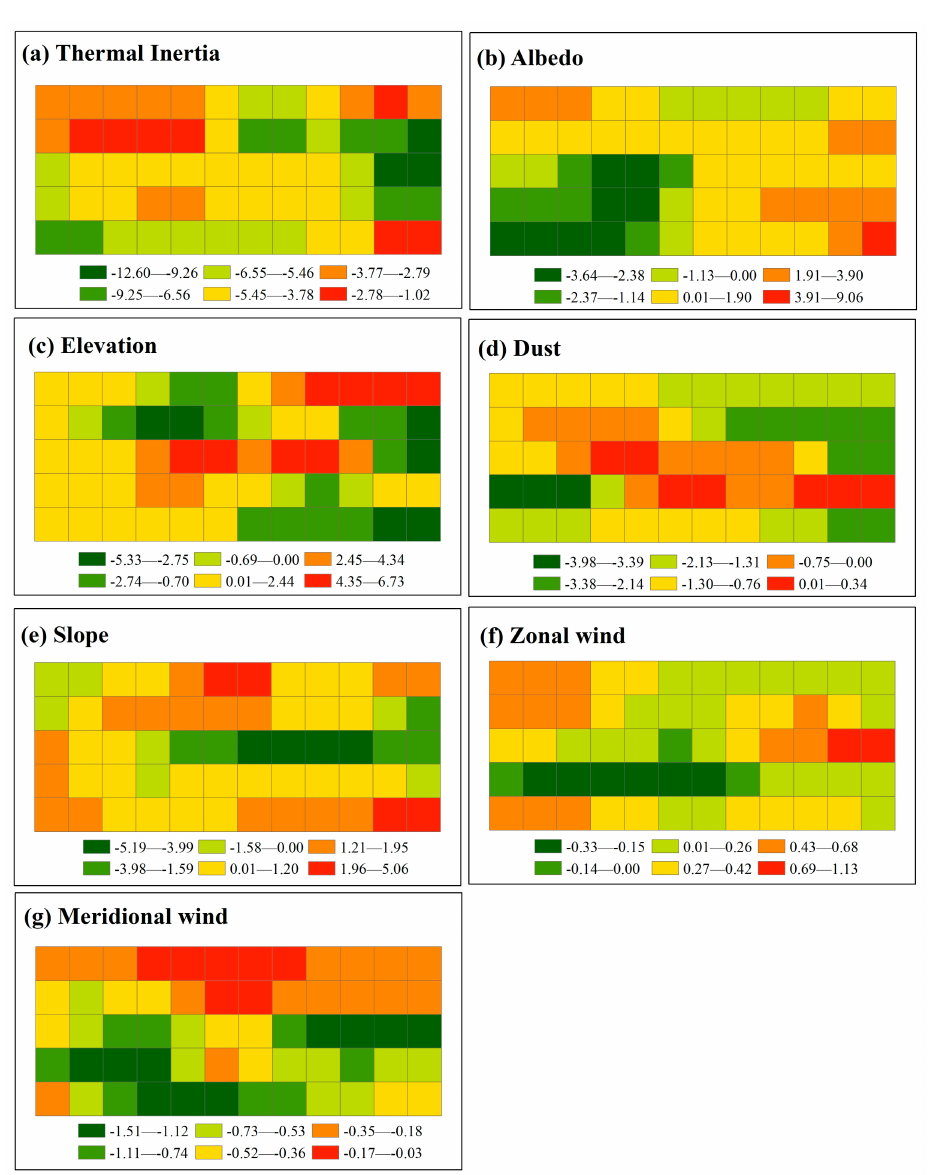
Figure 12. The distribution of the coefficients of the affecting factors (thermal inertia ( a ), albedo ( b ), elevation ( c ), dust ( d ), slope ( e ), zonal wind ( f ) and meridional wind ( g ) for